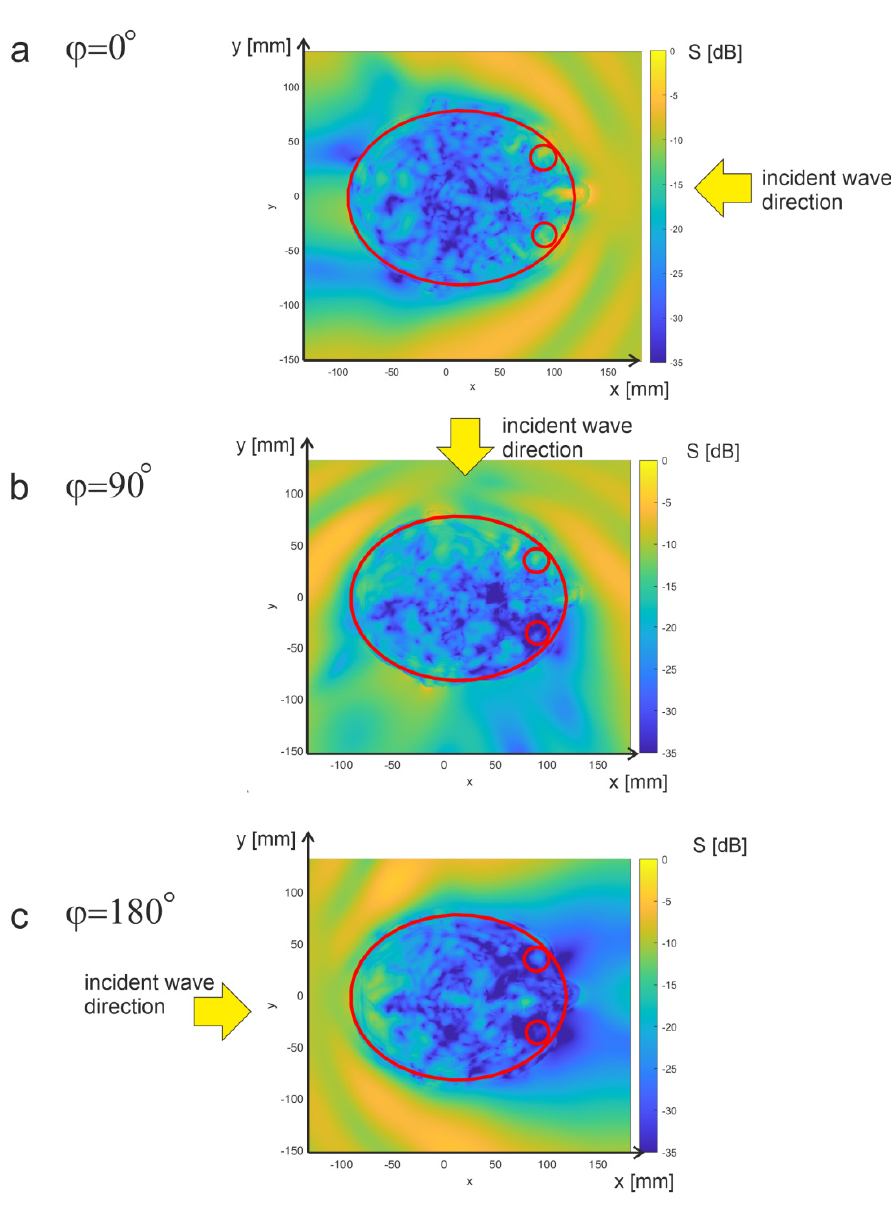
Figure 6. Power distributions obtained for θ = 90° and different angles in the horizontal plane. The head and the eyes are highlighted with red lines.